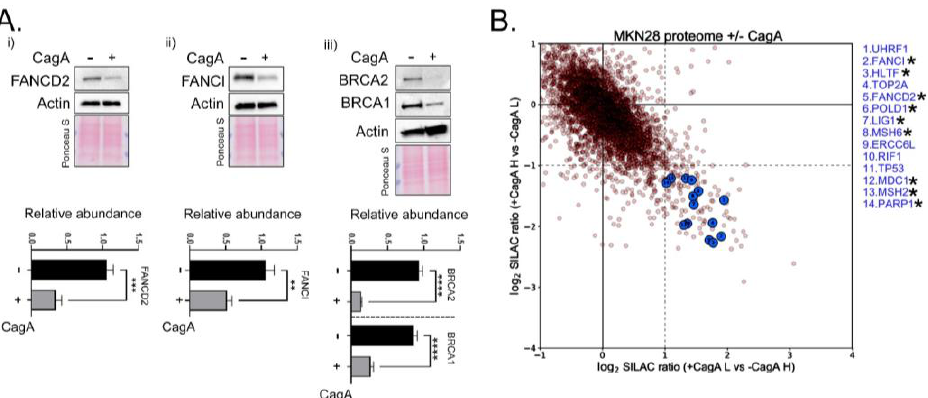
Figure 2. Protein level reduction in Fanconi Anemia and Homologous Recombination Factors ( A ). Dox-inducible MKN28 − CagA cells were either left untreated ( − CagA) or subjected to doxycycline withdrawal (+CagA) for 60 h and samples were harvested for Western blot and probed for FANCD2 (i), FANCI (ii), BRCA2 (iii), and BRCA1 (iii). Actin was used as the loading control. Below is the quantification of the blots from three independent experiments. Asterisks represent significant differences, * p < 0.05; ** p < 0.01; *** p < 0.001; **** p < 0.0001; ( B ) Plots represent proteins that are differentially expressed upon CagA induction (72 h). The cut-offs for significant differential expression was set to log2 (fold change) >1 across the forward (X-axis) and reverse (Y-axis) SILAC- based proteomic quantifications. Blue circles depict DNA repair proteins downregulated by at least 2-fold upon CagA expression across the two experiments. Asterisks are indicated against proteins that were also identified as DEGs following CagA expression. The complete plot is shown in Figure